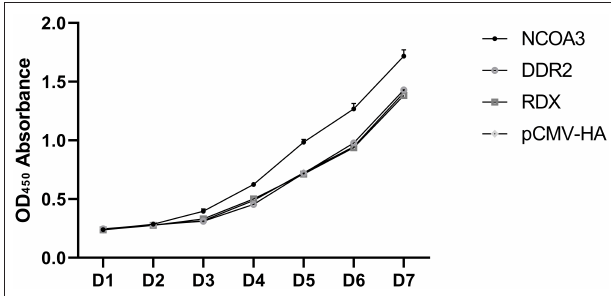
FIGURE 1 | The results of the CCK-8 assay to detect cell viability in seven days.